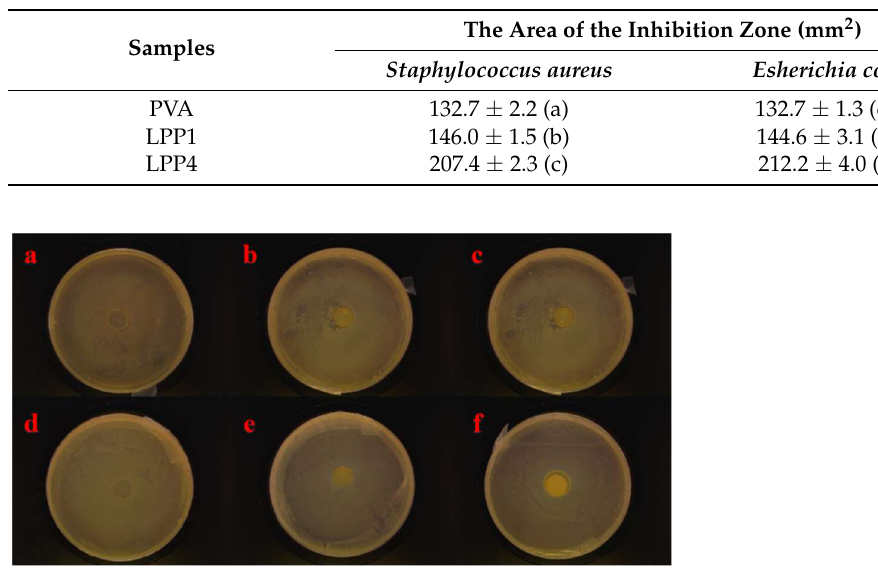
Figure 9. Antibacterial properties against S. aureus with ( a ) PVA, ( b ) LPP1, ( c ) LPP4 and E. coli with ( d ) PVA, ( e ) LPP1, ( f ) LPP4. ( d ) PVA, ( e ) LPP1, ( f )